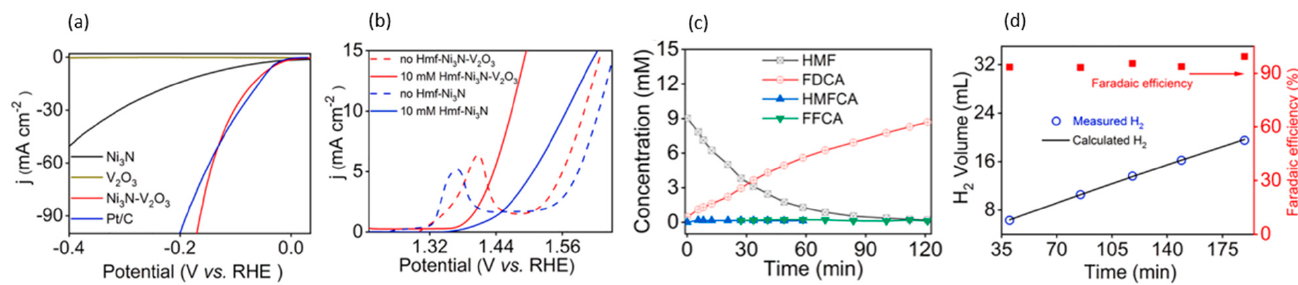
Figure 26. ( a ) LSV for Ni 3 N-V 2 O 3, Ni 3 N, V 2 O 3 and Pt/C cathodes. ( b ) LSV for Ni 3 N-V 2 O 3 and Ni 3 N anodes with and without 10 mM 5-HMF. ( c ) Concentrations of 5-HMF and products over time, in two-electrode test cell, 1 M KOH, 10 mM 5-HMF, chronopotentiometric test at 10 mA/cm 2 , Ni 3 N-V 2 O 3 anode and cathode. ( d ) Theoretical and actual production of hydrogen gas. Reprinted with permission from Ref. [120]. Copyright 2021, Chemical Engineering